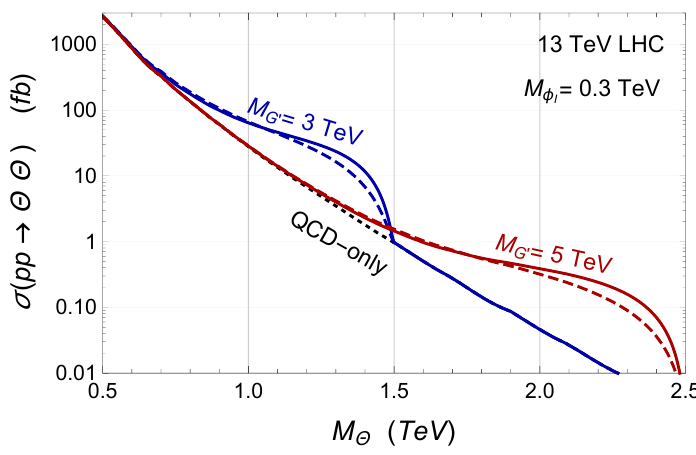
Figure 6 . Leading-order cross section for (cid:2)(cid:2) production (due to an s -channel G interference) at the 13 TeV LHC as a function of the (cid:2) mass. The coloron mass is (cid:12)xed at M G 3 TeV (blue lines) or 5 TeV (red lines), while tan (cid:18) = 0 : 2 (solid lines) or 0.5 (dashed lines). The dependence on the neutral-scalar mass ((cid:12)xed here at M (cid:30) represents the QCD